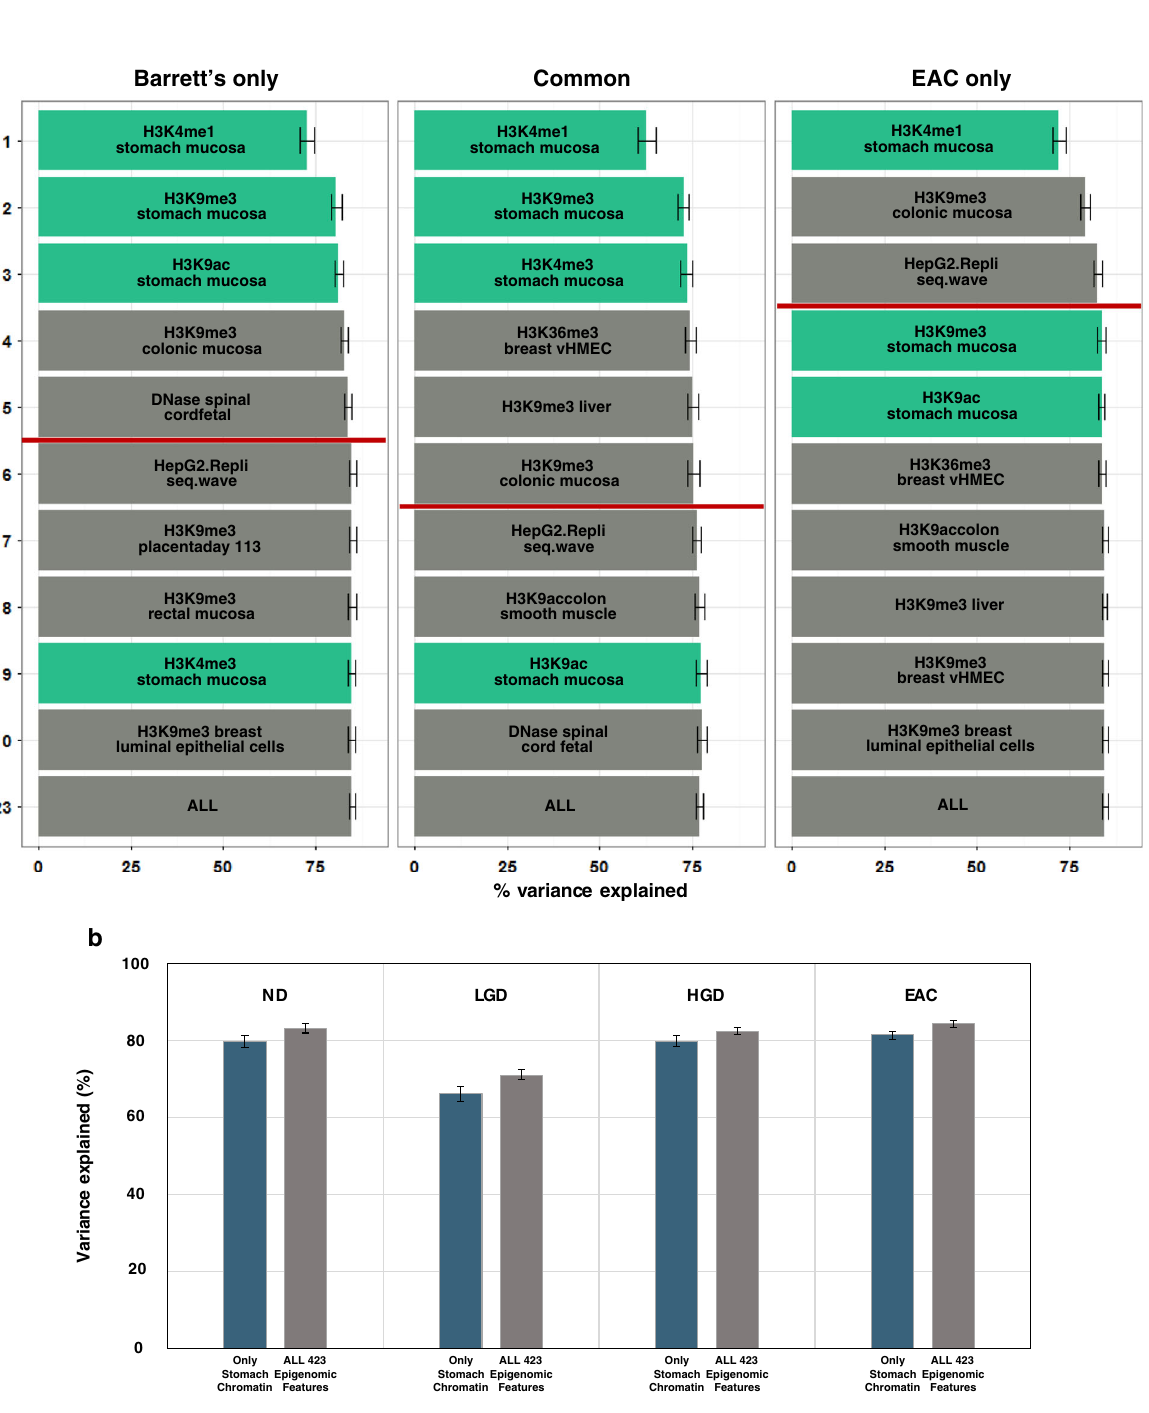
Fig. 3 Regional mutation frequency landscape of Barrett ’ s esophagus and matching esophageal adenocarcinoma are affected by cell-type- shift-associated epigenetic changes. a Chromatin feature selection based on the commonality of mutations in paired samples of Barrett ’ s esophagus and esophageal adenocarcinoma. Barrett ’ s only: mutations observed only in the Barrett ’ s esophagus genome, Common: mutations observed in common for both Barrett ’ s esophagus and esophageal adenocarcinoma genomes, EAC only: mutations observed solely in the esophageal adenocarcinoma genome. b Bar graph representing average variance explained scores using either stomach chromatin features ( navy ) or all 423 epigenomic features ( gray ). ND: no dysplasia, LGD: low-grade dysplasia, HGD: high-grade dysplasia, EAC: esophageal adenocarcinoma. Error bars demonstrate minimum and maximum values derived from 1000 repeated Finally, analyses results from BE and EAC also raise the mutations using various types of mutagens to examine the effect possibility that epigenetic changes due to environmental insults, of different epigenetic features on shaping mutation landscape, represented as a cell type shift, could serve as a primary role for which could be one of the strong candidates for any follow-up establishing the mutation landscape of at early stage of cancer research.